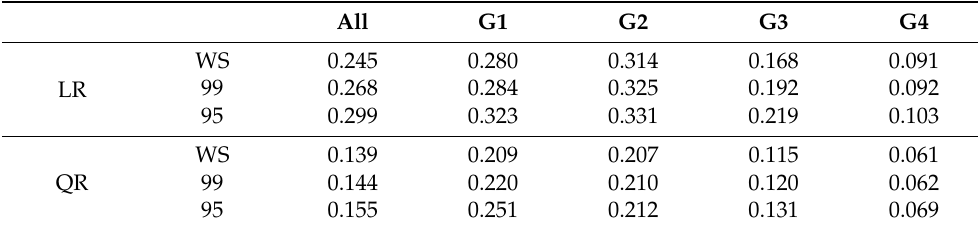
Table 2. Goodness of fit of the models.